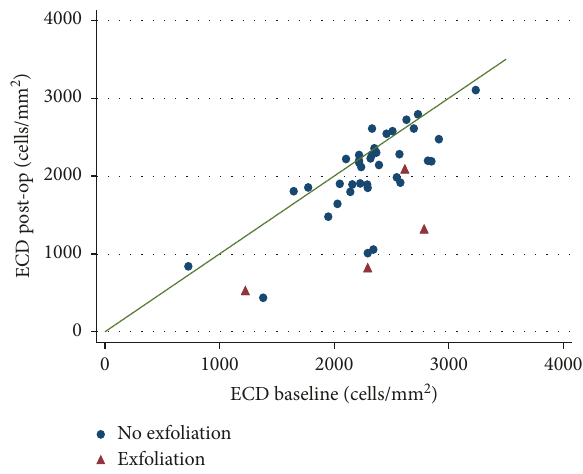
Figure 1: Pre-post graph of changes in endothelial cell density (ECD). The green line represents no